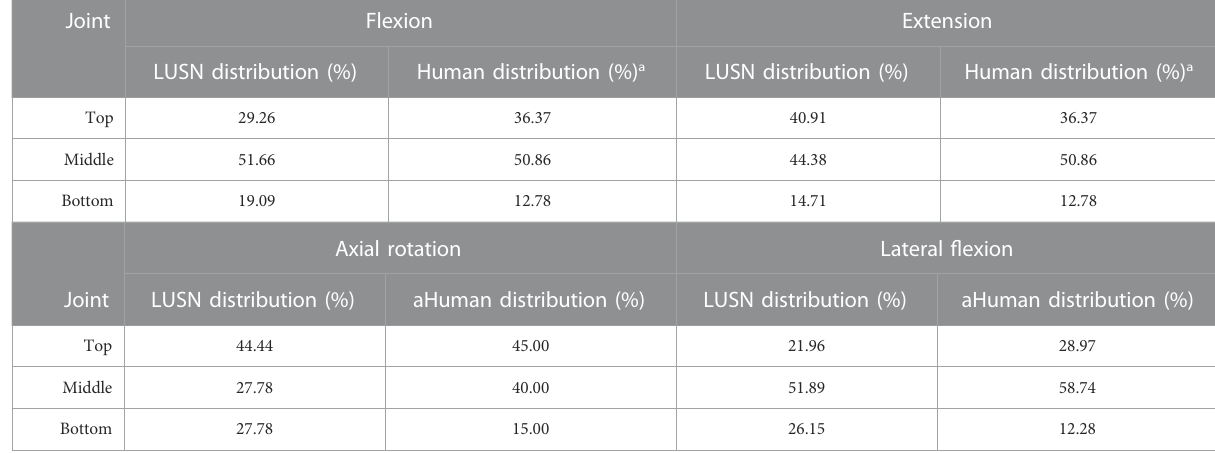
TABLE 4 The comparative percentage distribution of the total ROM across the joints of the LUSN and the equivalent summation across the human intervertebral joints in fl exion, extension, axial rotation and lateral fl